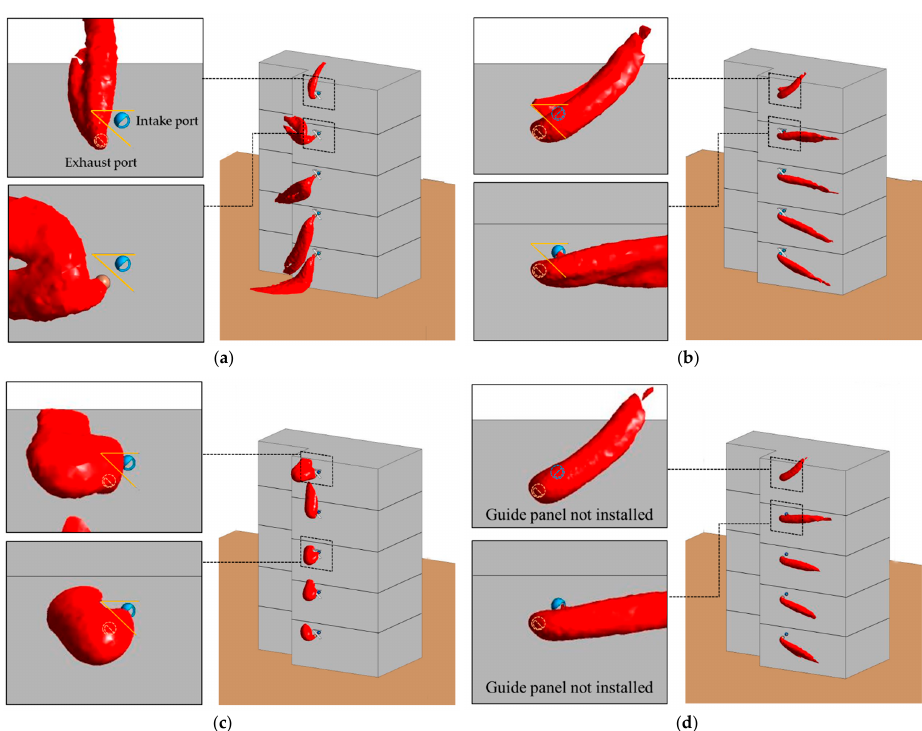
Figure 9. The scope of the exhaust air diffusion (iso-surface): ( a ) Case 1; ( b ) Case 4; ( c ) Case 7; ( d ) Case 10.